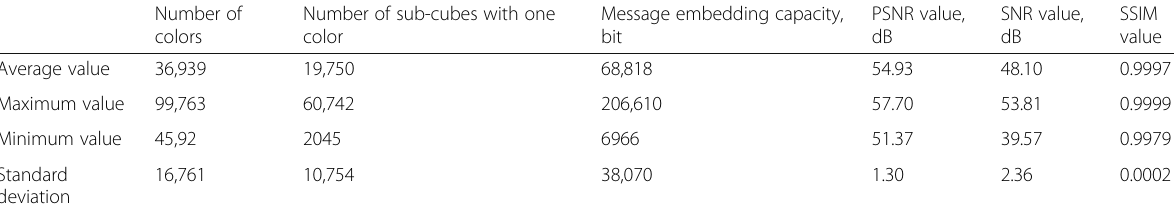
Table 3 Message embedding measurements for BSD-300 image dataset images Number of Number of sub-cubes with one colors color